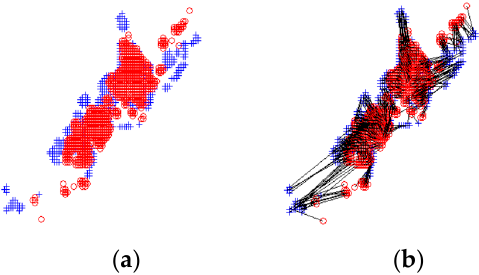
Figure 6. An instance of the shape contexts matching. ( a ) The segmented image of the query ship and ship template; ( b ) The shape contexts matching result of the query ship and ship template. Query ship (red), Ship template (blue).